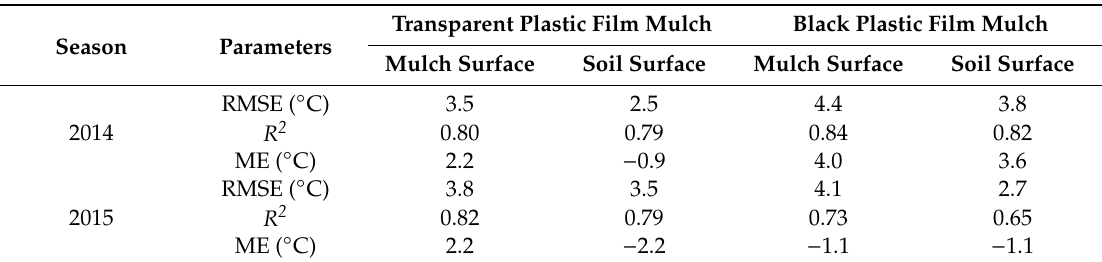
Table 4. The root mean square errors (RMSE), coe ffi cient of determination ( R 2 ), and mean errors (ME) in simulated and observed hourly temperatures on the mulch surface and soil surface for transparent plastic film mulch and black plastic film mulch treatments at Wuwei, China.